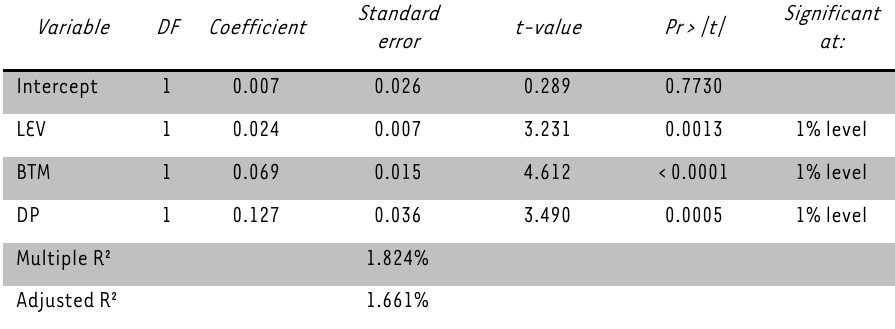
TABLE 4: Regression model with three significant